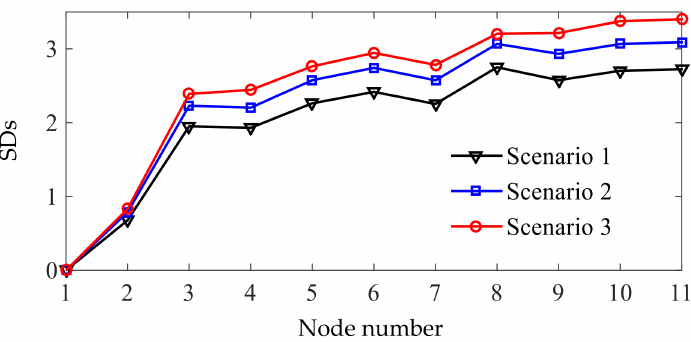
Figure 20. SDs of the nodal pressures in the gas